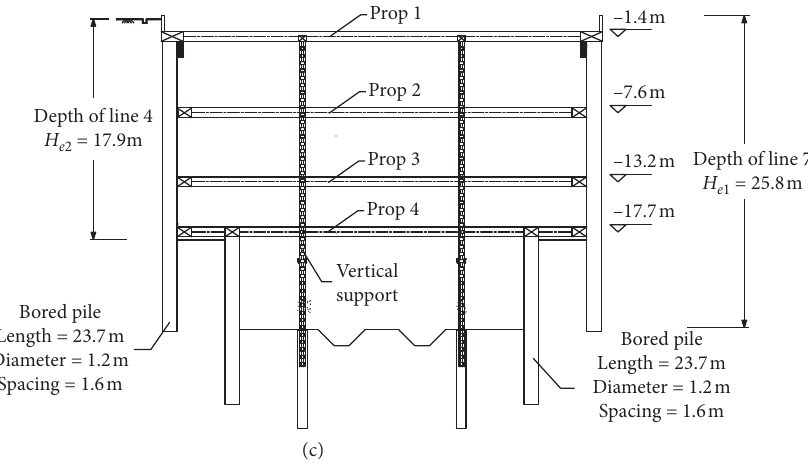
Figure 4: Plan view at the intersection of the two subway lines (a) and the two cross sections: A-A (b) and B-B